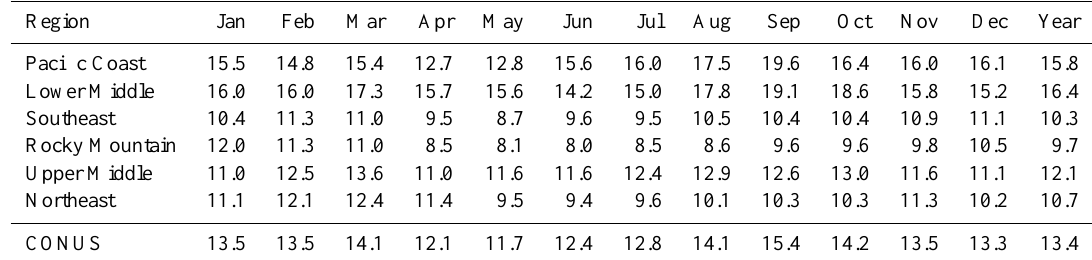
Table 4. Monthly and annual averaged NO 2 RMSEs in different regions and CONUS in 2010. Unit: ppbv. Region